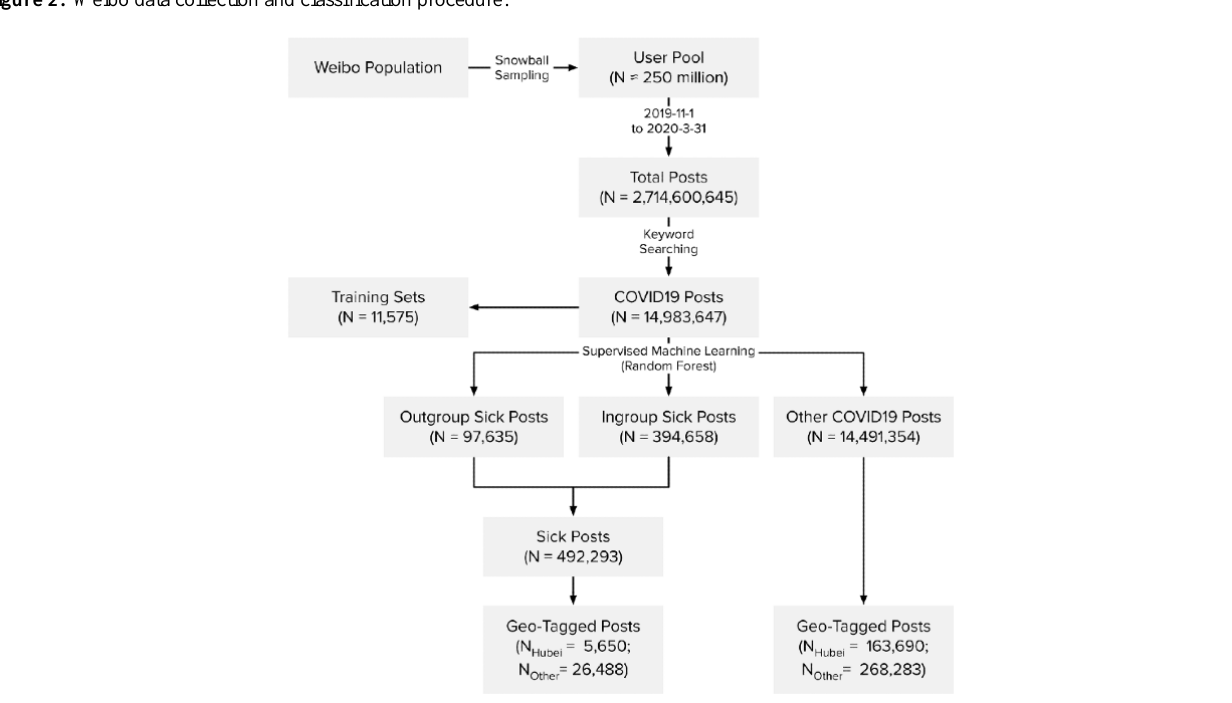
Figure 2. Weibo data collection and classification